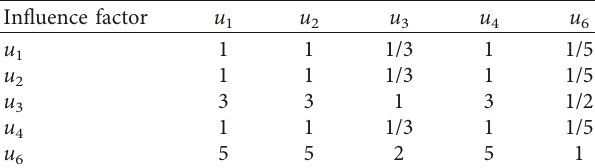
Table 7: Judgment matrix for influence factors in the operating period.